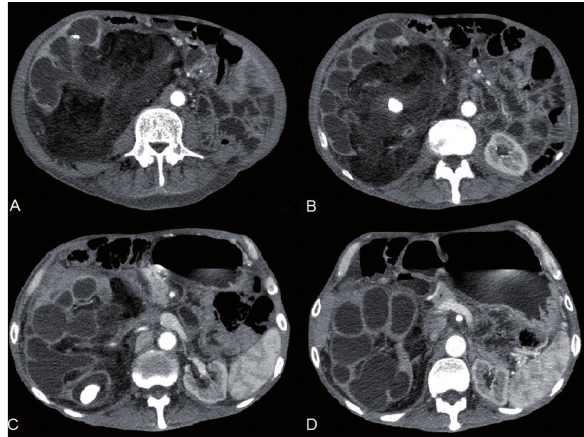
figure 2 - Axial post-contrast cT images show obstructive stones, dilated calyces and renal parenchymal atrophy on the right kidney. Exuberant fibrofatty proliferation in renal sinus, indicating renal replacement lipomatosis (A, B and c).calyceal dilatation with a multiloculated aspect similar to the toe pads of a bear’s paw in XGp (D).